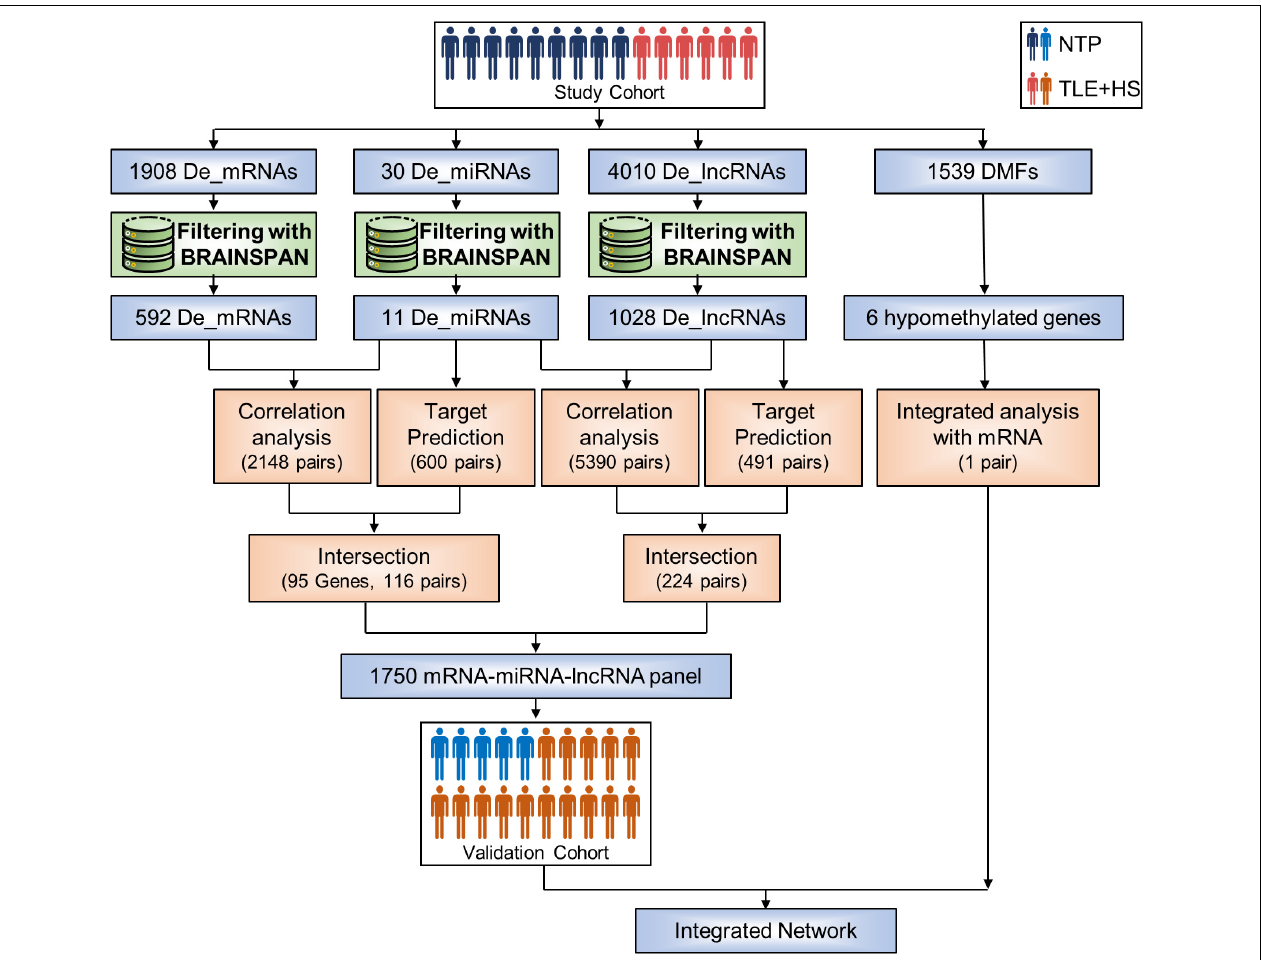
FIGURE 1 | Sample groups and analysis process. Flowchart summarizing the study design and methods used. De_mRNAs, differential expressed mRNAs; De_miRNAs, differential expressed micro RNAs; De_lncRNAs, differential expressed long non-coding RNAs; DMFs, differentially methylated fragments; NTP, normal temporal or parietal cortices; TLE+HS, epilepsy with hippocampal